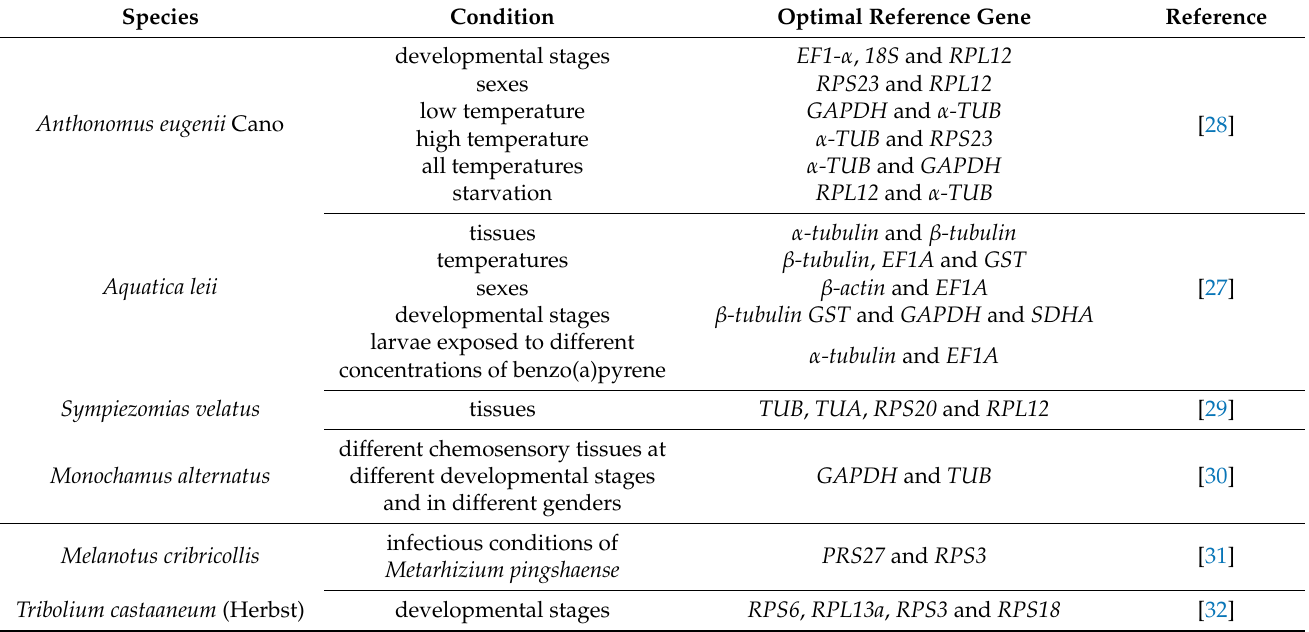
Table 1. Suggested stable reference genes in some Coleoptera species with different experimental